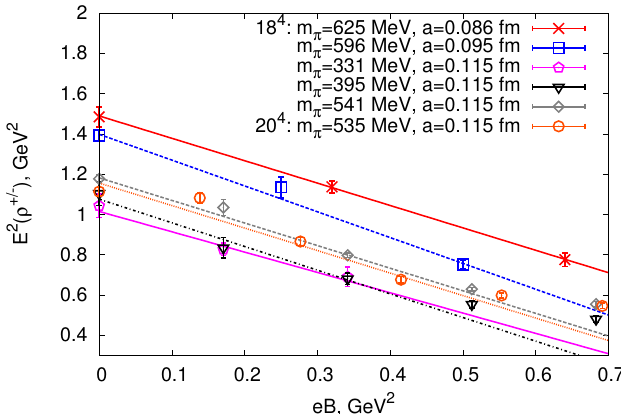
Figure 4. The energy squared of the (cid:26) + ( (cid:26) (cid:0) ) meson with the spin projection s z = +1 ( s z = (cid:0) 1) versus the magnetic (cid:12)eld value for various lattice volumes, lattice spacings and di(cid:11)erent quark masses. The points correspond to the lattice data, the lines are the (cid:12)ts to these data obtained using formula (3.2).